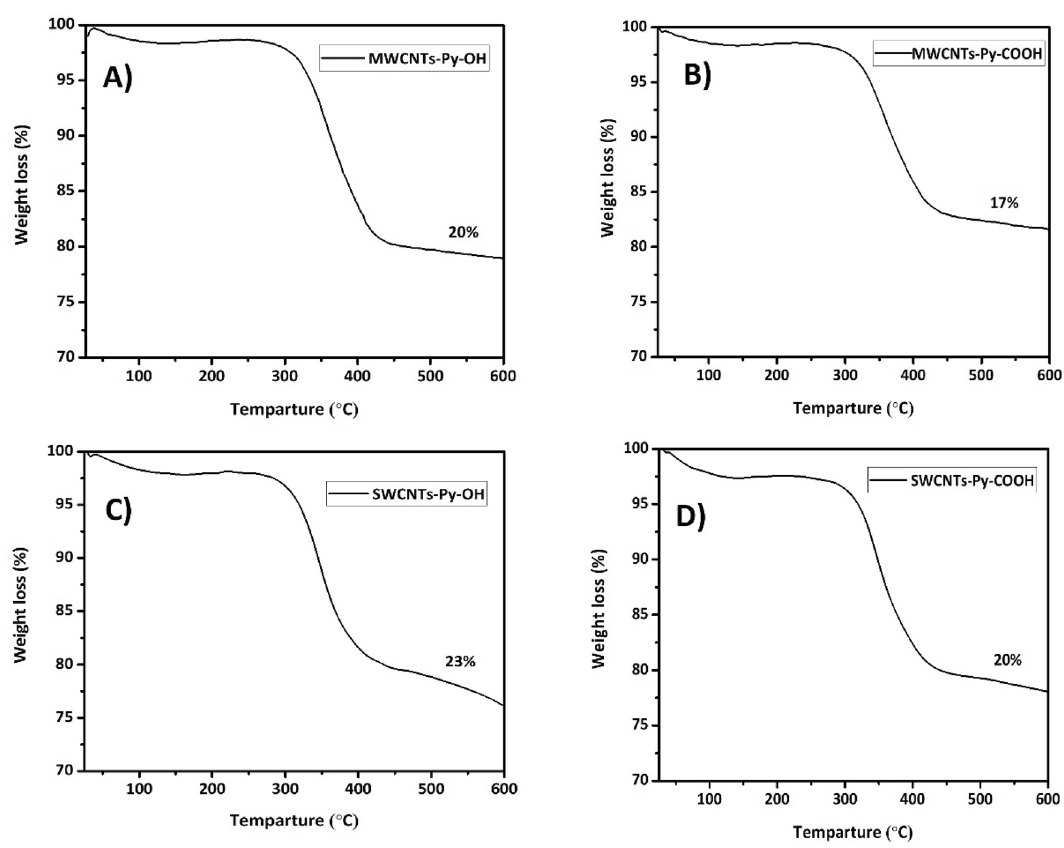
Figure 7. TGA analysis of all f -CNTs: ( A ) MWCNTs-Py-OH; ( B ) MWCNTs-Py-COOH; ( C ) SWCNTs-Py-OH and ( D ) SWCNTs-Py-COOH.